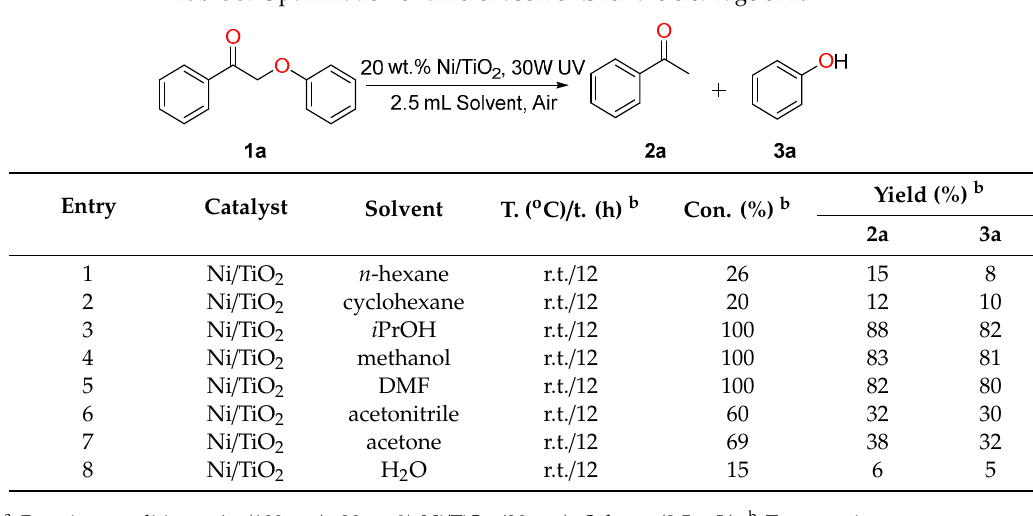
Table 3. Optimization of different solvents for the cleavage of 1a a .